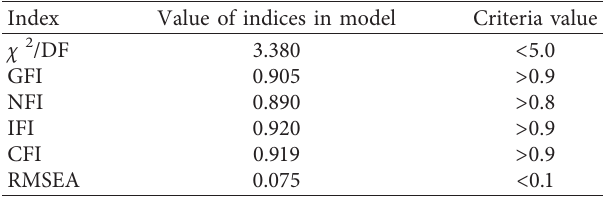
Figure 4: Measurement and structural model with standardized estimates. Table 3: Overall fit indices for